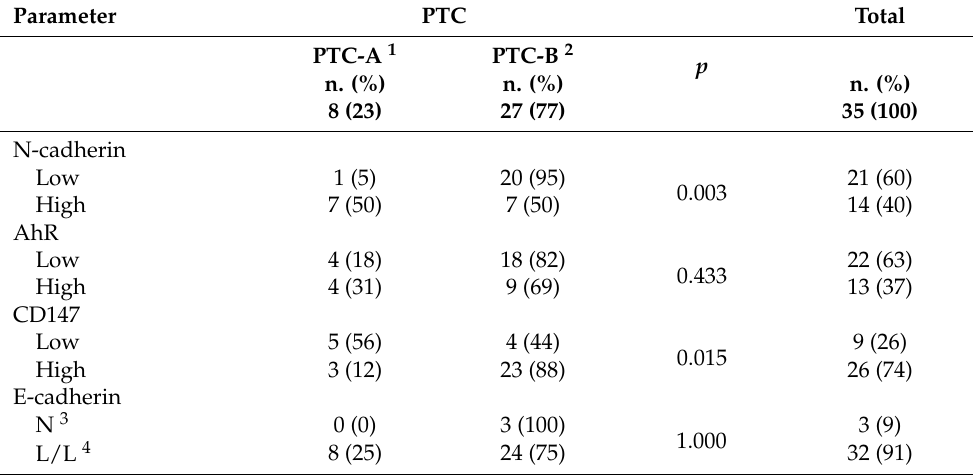
Table 7. PTC-A and PTC-B associations with